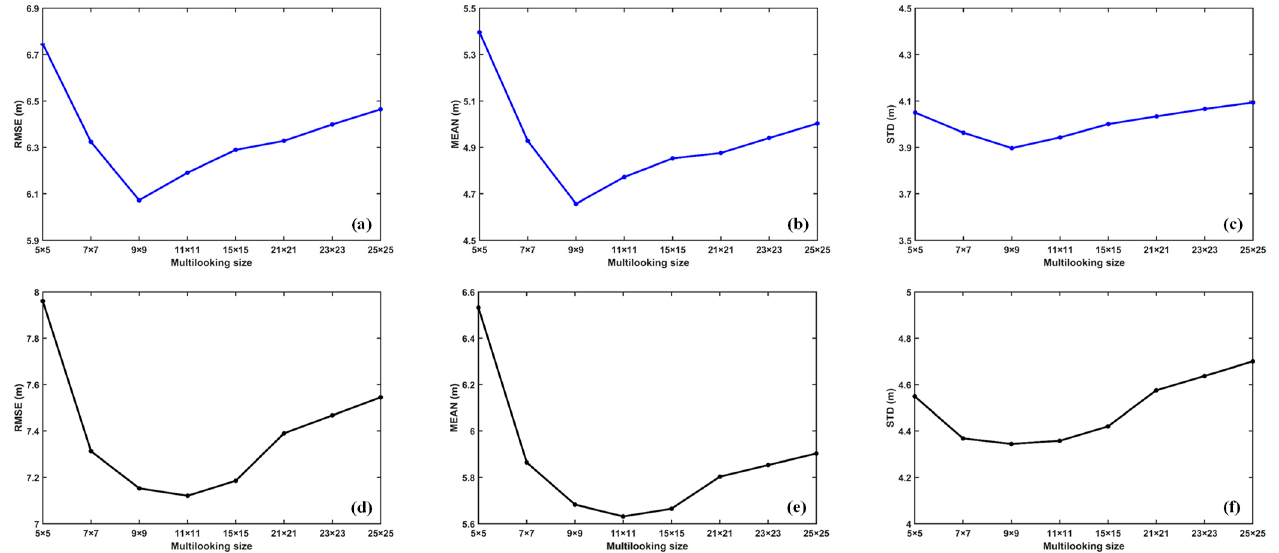
Figure 13. Three statistical indicators based on estimation errors from the Mabounie and Mondah areas: ( a ) RMSE from the Mabounie area; ( b ) MEAN from the Mabounie area; ( c ) STD from the Mabounie area; ( d ) RMSE from the Mondah area; ( e ) MEAN from the Mondah area; ( f ) STD from the Mondah area.